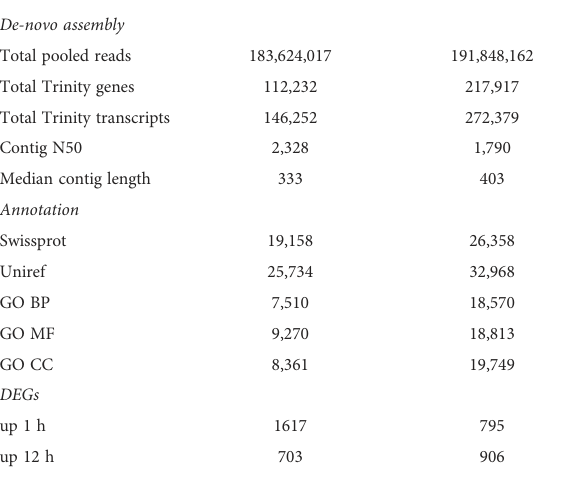
TABLE 2 RNA-seq data resulting from PBLs collected from Dicentrarchus labrax and Rattus norvegicus treated for 1 h and 12 h with Anisakis crude extract (also untreated PBL for each species and condition were included in the assembly and annotation analyses, whereas only treated samples were used for differential expression